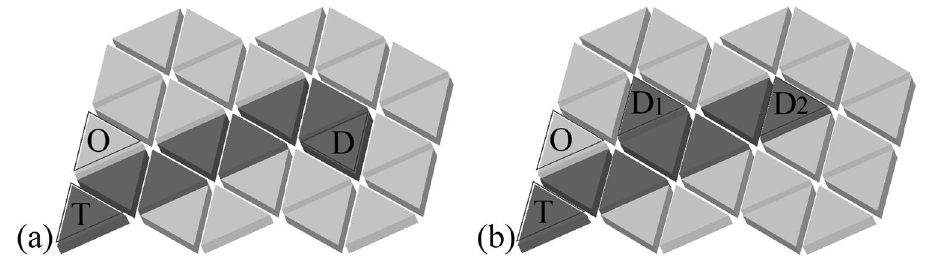
Figure 1. The two-dimensional power transfer plane that consists of resonant units. Dark grey triangles are activated units, and light grey triangles are inactive units. ( a ) One receiver. ( b ) Two